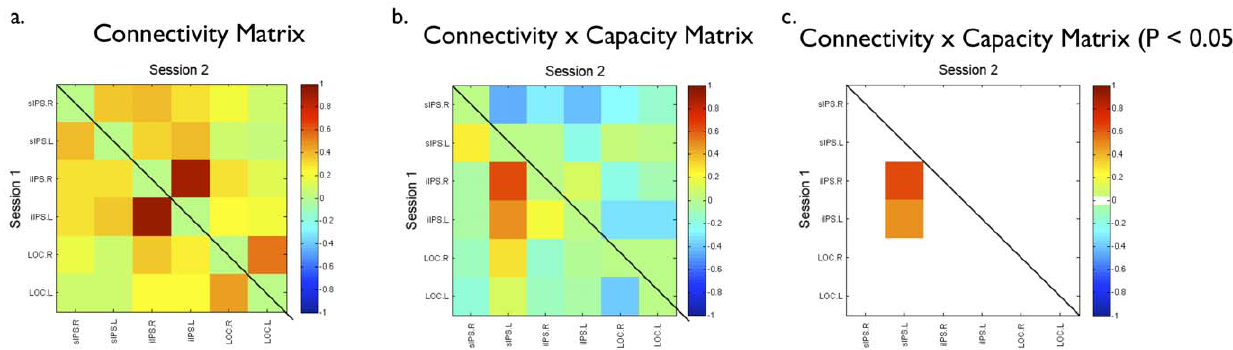
Figure 5. Connectivity matrix for the six regions of interest from Xu & Chun (2006). The matrices indicate a) the intercorrelations among node-pairs for Session 1 (lower triangle) and Session 2 (upper triangle), b) the correlation between VSTM capacity and the strength of correlation for each node pair at Session 1 and Session 2, and c) the same matrix as in b but set to a threshold of r=0.47, p=0.05, uncorrected for multiple comparisons. Abbreviations of anatomical locations: sIPS.R - Right superior intra-parietal sulcus, sIPS.L - Left superior intra-parietal sulcus, iIPS.R - Right inferior intra-parietal sulcus, iIPS.L - Left inferior intra-parietal sulcus, LOC.R - Right lateral occipital cortex, LOC.L - Left lateral occipital cortex.